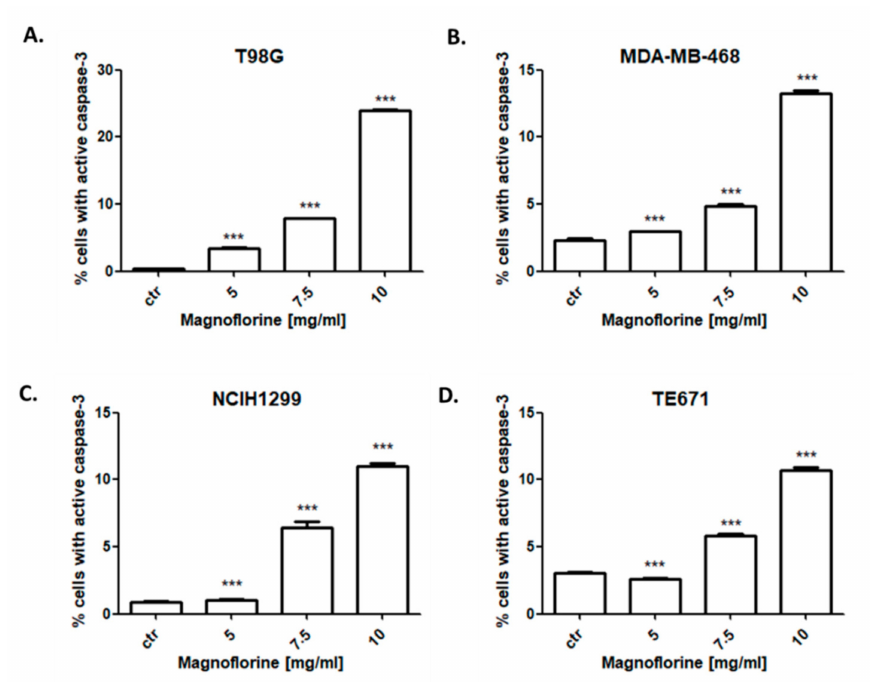
Figure 5. E ff ects of magnoflorine (MGN) on caspase-3 activation in T98G glioma ( A ), MDA-MB-468 breast ( B ), NCIH1299 lung ( C ), and TE671 rhabdomyosarcoma ( D ) cancer cells. Cancer cell lines were cultivated for 48 h with di ff erent doses of MGN (5–10 mg / mL) and analyzed by flow cytometry. The values present the percentage of the cells with active caspase-3. The results are depicted as means ± SD, n = 9 from three separate experiments. Statistical analysis was performed using one-way ANOVA test. *** p < 0.001.